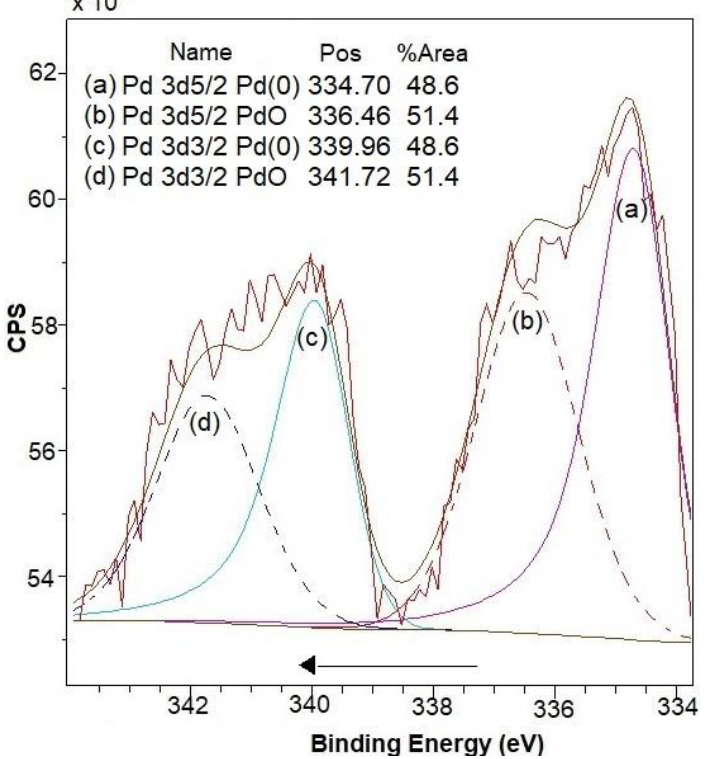
Figure 4. High-resolution X-ray photoelectron spectroscopy (XPS) spectra for 1.00 wt% Pd – TiO 2. Note: Full lines represent Pd (0) at (a) 3d5/2 and (c) 3d3/2. Broken lines represent PdO at (b) 3d5/2 and (d) 3d3/2.